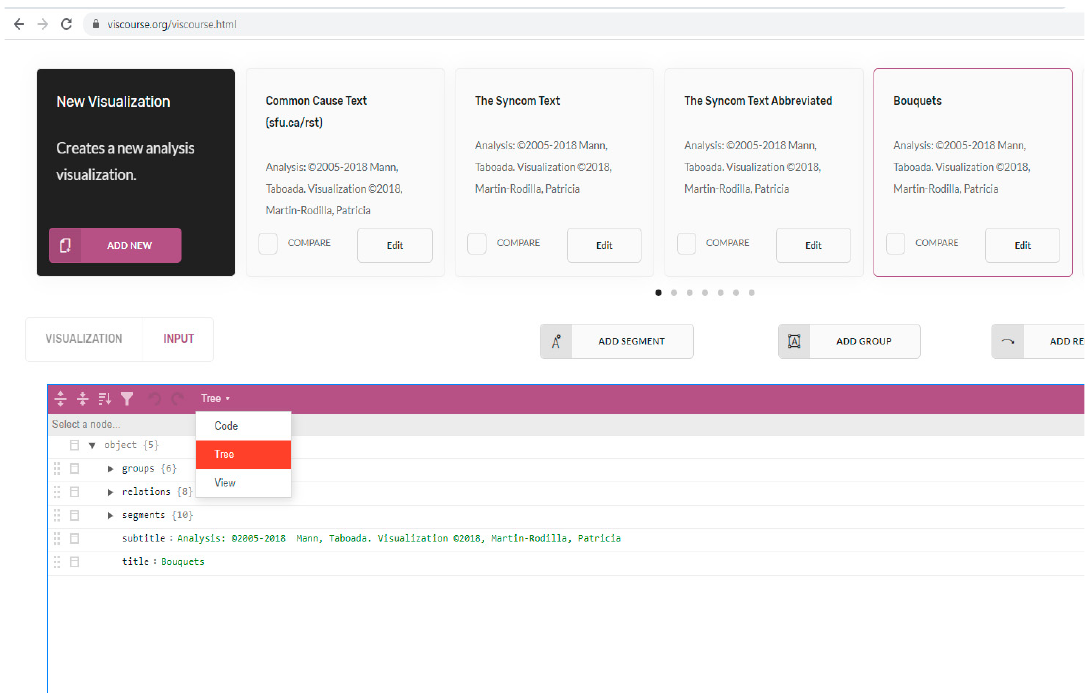
Figure 4. Viscourse classic import/export mechanisms through editable JavaScript Object Notation (JSON) files from the Viscourse web platform, with three options for JSON file view: code, tree or a node view.